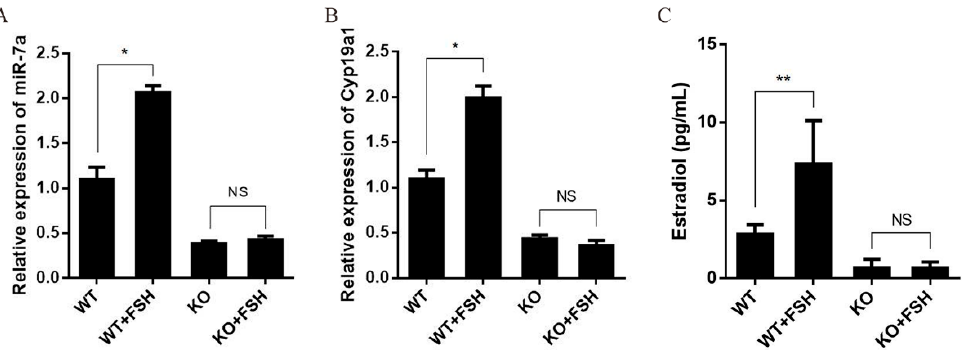
Figure 6. MiR-7a regulates the estrogen synthesis by FSH. ( A ) FSH increases the relative expression of miR-7a2 in the primary granulosa cells of WT mice. ( B ) Relative expression of Cyp19a1 in mouse primary granulosa cells. ( C ) Effect of FSH on estrogen levels in the culture medium. * p < 0.05, ** p < 0.01. NS, not significant. ** p < 0.01. NS, not